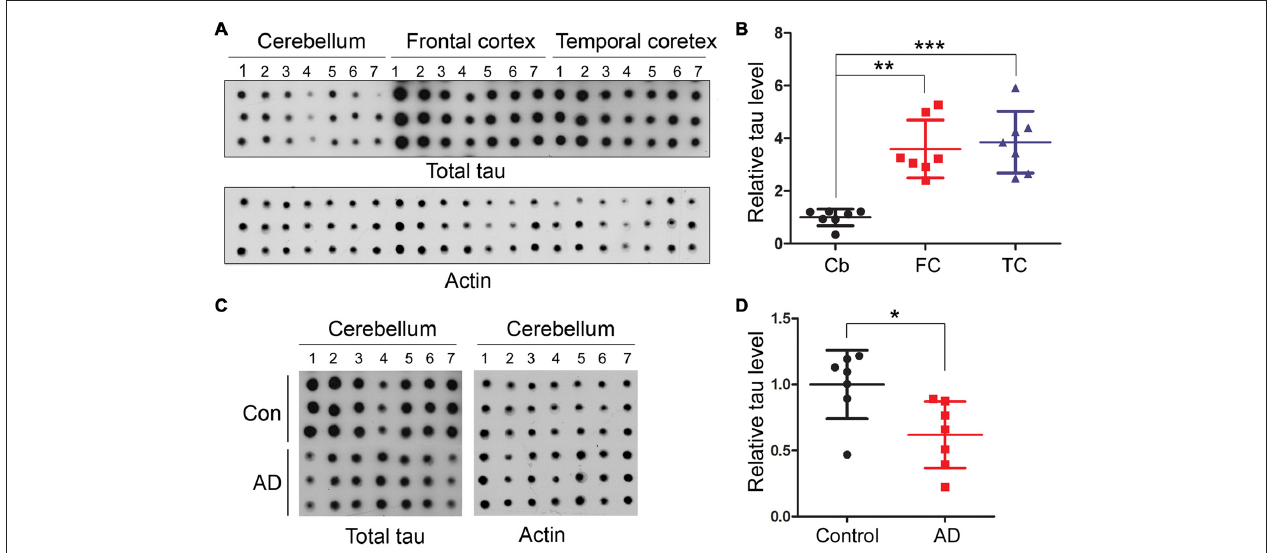
FIGURE 3 | Human cerebellum expresses much less tau than the frontal or temporal cortex. Same amount of brain crude extract protein was dotted in triplicates on nitrocellulose membrane and developed with tau antibody (R134d) against total tau or β -actin as a loading control (A,C) . The level of tau was normalized by actin ( n = 7, B,D ). ∗ P < 0.05; ∗∗ P < 0.01; ∗∗∗ P < 0.001. Cb, cerebellum; FC, frontal cortex; TC, temporal cortex.